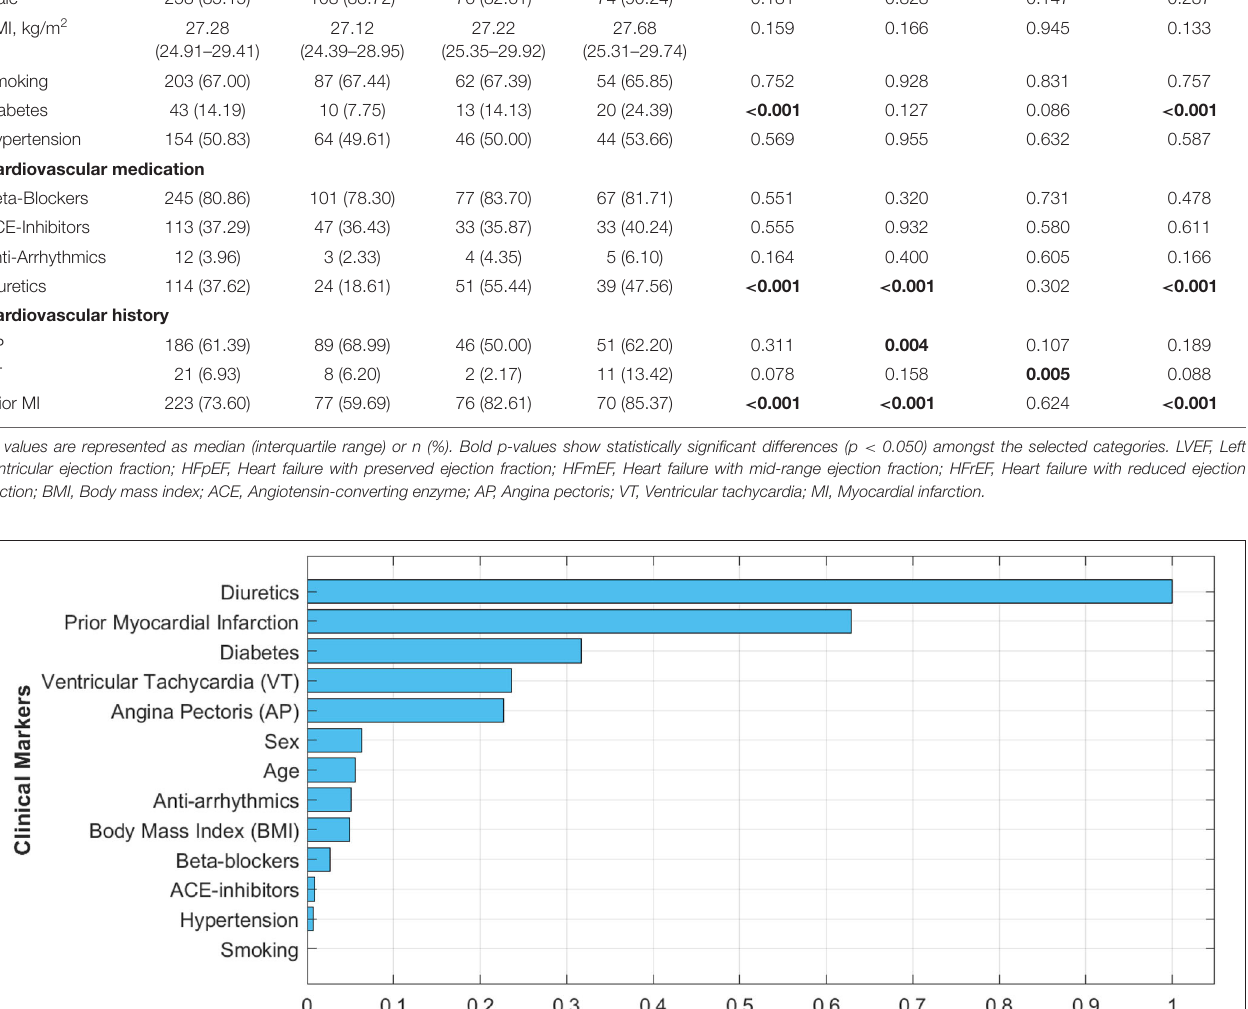
level of 93.00, 89.10, and 95.10% for HFpEF, HFmEF, and HFrEF, respectively. The model resulted in an average AUROC of 0.975 ( Figure 5B ) distributed as 0.986 for HFpEF, 0.955 for HFmEF, and 0.983 for HFrEF. Furthermore, the model achieved high